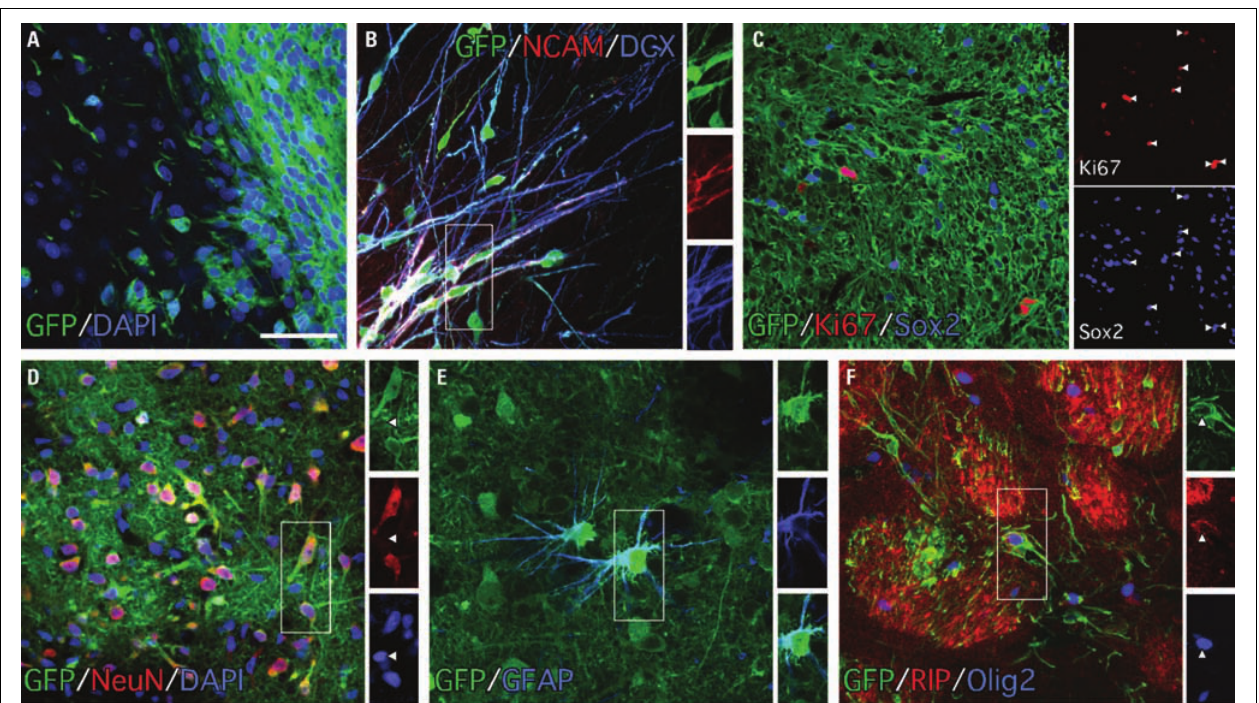
FIGURE 4 |The grafts were composed of immature and differentiated neural cell types as revealed by immunochemistry for GFP and phenotypic markers 10 weeks after transplantation. (A) Staining for DAPI (blue) and GFP (green) shows the densely packed graft core at the periphery of the graft within the GFP − host tissue. (B) Many of the cells with migrating neuroblast morphology expressed both doublecortin (blue) and PSA-NCAM (red; boxed area enlarged as single color channels). (C) The grafts contained a population of dividing (Ki67 + , red) cells 10 weeks after transplantation and